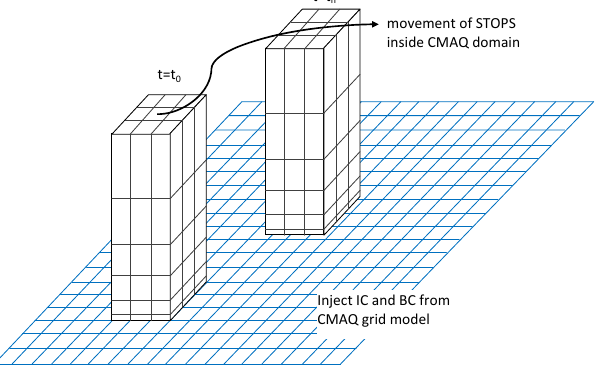
Figure 1. The conceptual model of STOPS and its movement inside the CMAQ